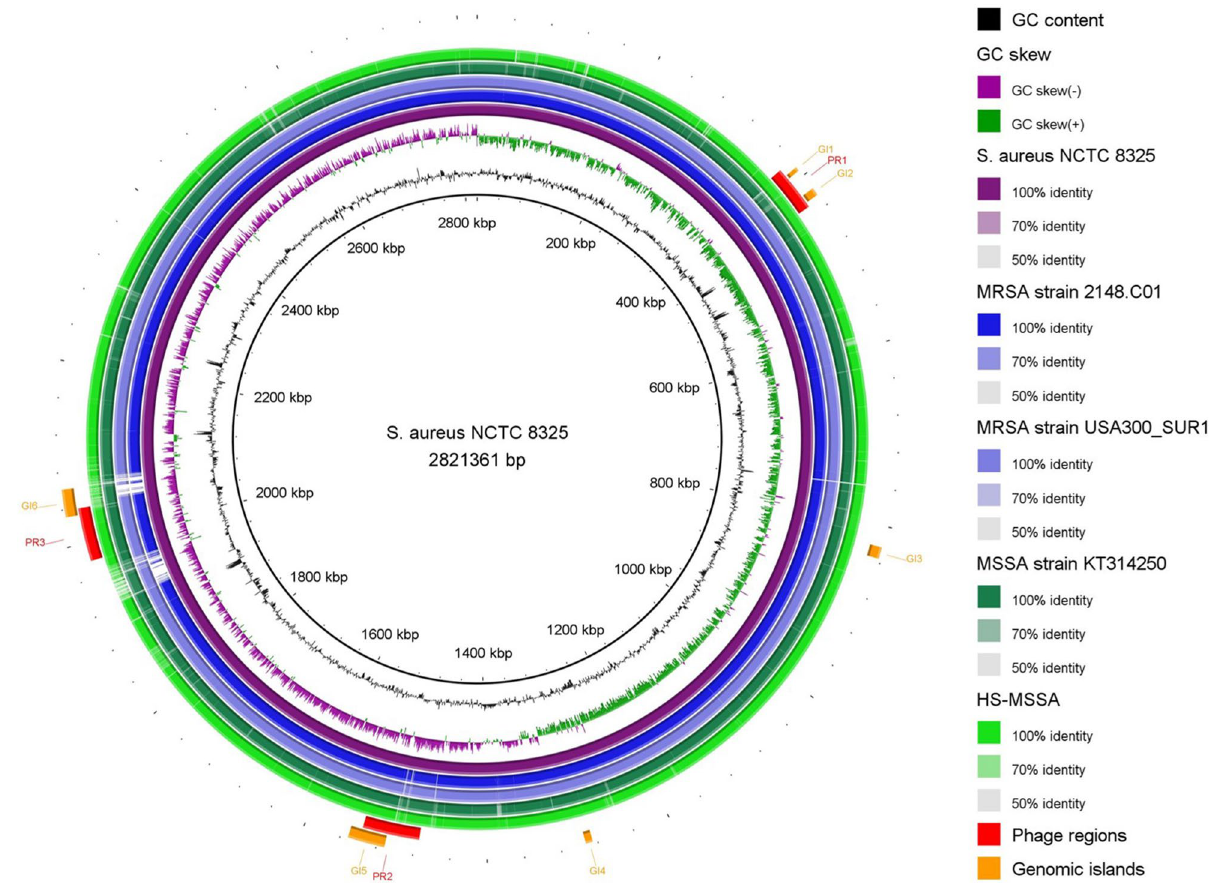
Figure 1. Genome map of the representative MRSA and MSSA strains. The genome map was generated using BLAST Ring Image Generator (BRIG) 24 . The genomes of two MSSA strains isolated in Malaysia (HS-MSSA and KT/314,250) and two community acquired MRSA clones (2148.C01 and USA300_SUR1 isolated in the North and South America respectively) were mapped to the reference genome S. aureus NCTC 8325. From the inner to the outermost ring, the first (innermost) ring shows the genome size in kbp, followed by GC skew (purple and green), GC content (black), S. aureus NCTC 8325 (purple), MRSA strain 2148.C01 (dark blue), MRSA strain USA300_SUR1 (light blue), MSSA strain KT/314,250 (dark green), and HS-MSSA strain (light green). The predicted phage regions (red) and genomic islands (orange) in the HS-MSSA genome are shown in